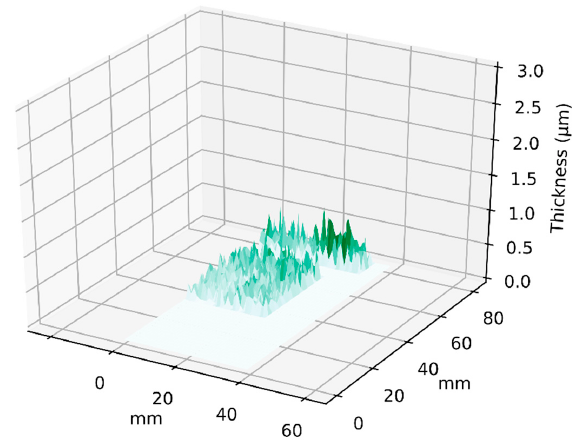
Figure 6. 3D heightmap of calculated thickness values for AoIs B and C.